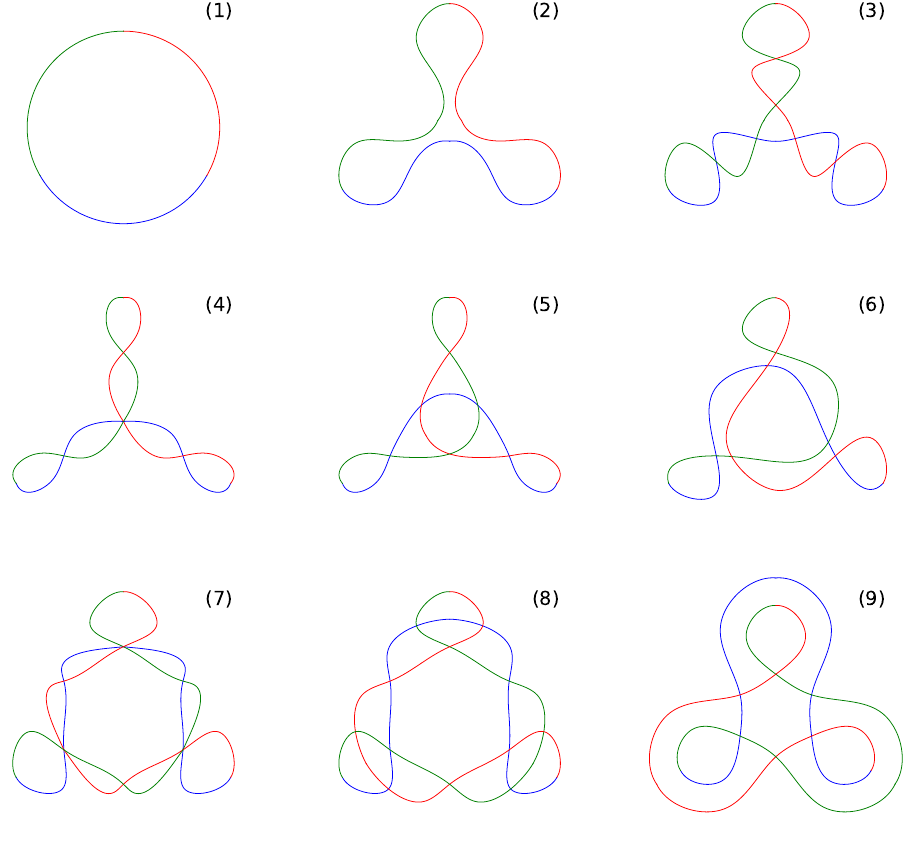
Figure 8: Several cuts of the cylinder, at different z , whose first free edge (1) will be connected to the disk and the second free edge (9) to the surface k ∪ k (cid:48) along its z = 0 edge (Fig. 7). Each crossing is a double point and there are 4 triple points in (4) and (7). In between steps (5) and (7), the mirror plane perpendicular to the plane of the figure is broken: a chirality is chosen which must map the chirality of the sheet k ∪ k (cid:48)